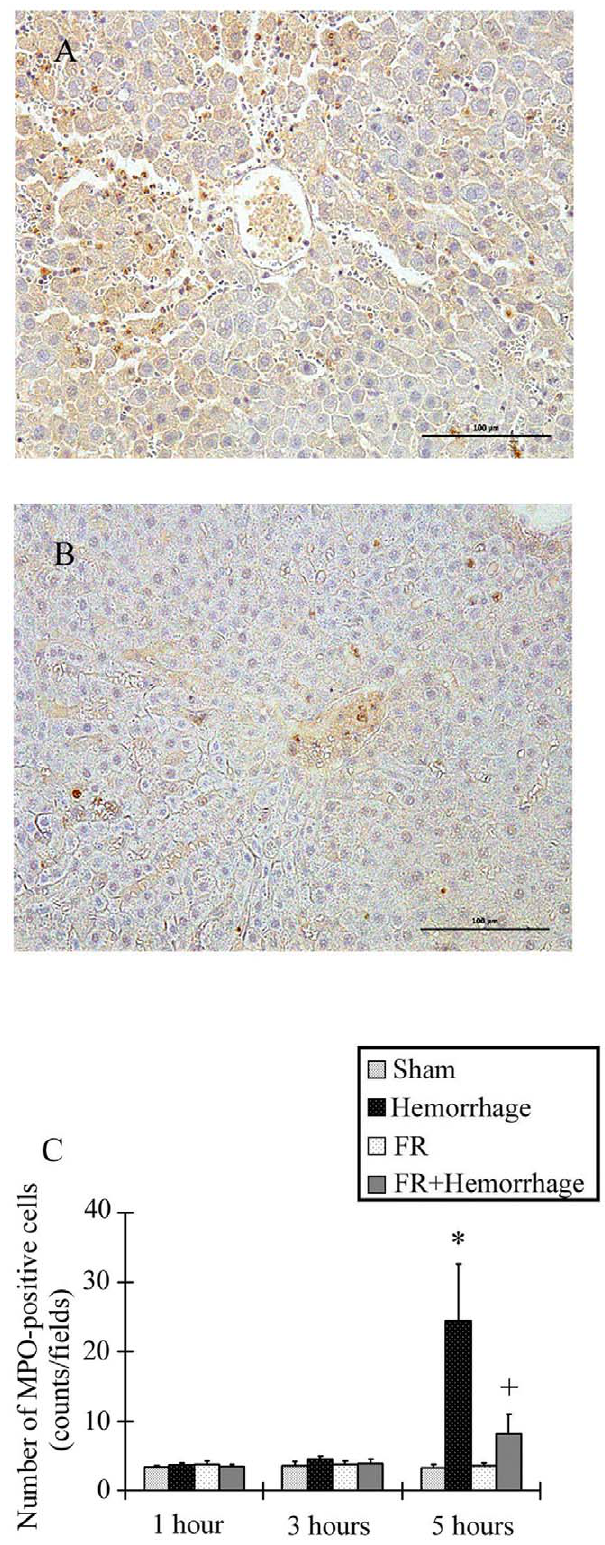
Figure 8. Light micrograph showing the liver at 5 hours post- hemorrhage. The interstitial space was edematous and the sinusoidal capillaries were dilated with diffuse congestion. Some neutrophils, which have the appearance of reddish brown precipitates, were present in the sinusoidal cavity and interstitial space in the Hemorrhage